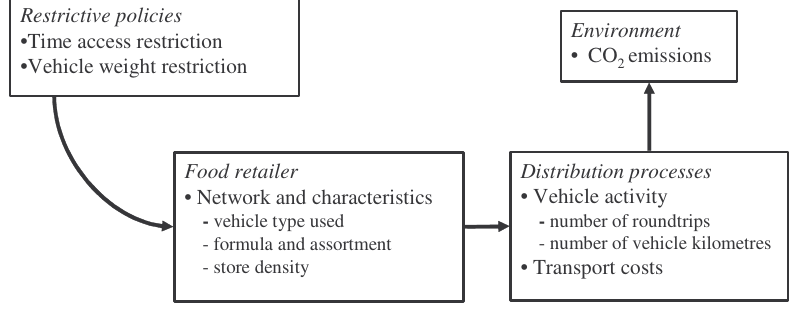
Figure 1. Research